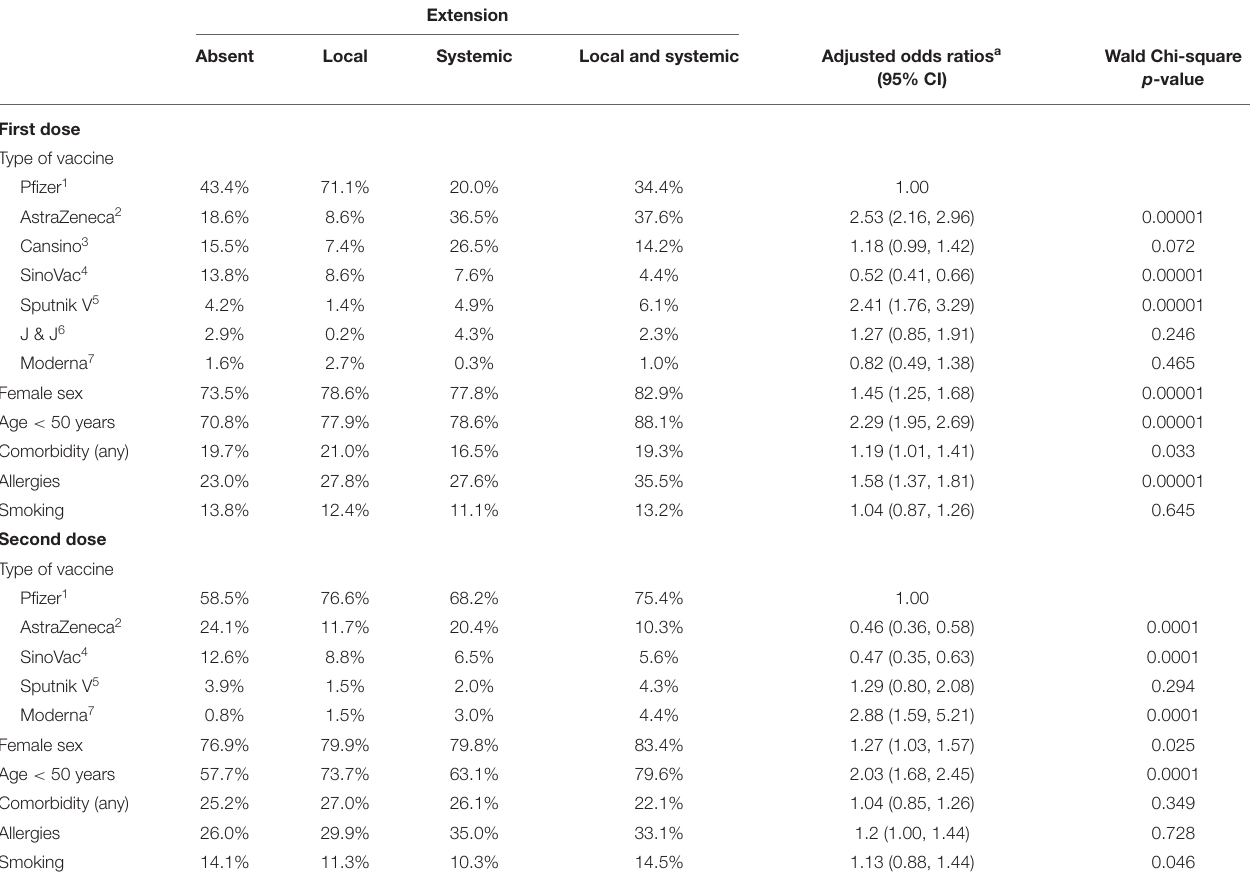
TABLE 5 | Multivariate ordinal regression analyses of factors associated to an extension of side effects in Mexican population, August to September 2021. Extension Absent Local Systemic Local and systemic Adjusted odds ratios a